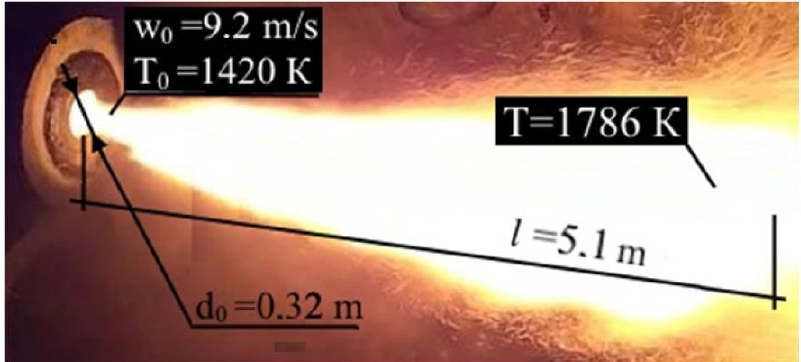
Figure 5. Experimental study of combustion on the E-160 boiler.